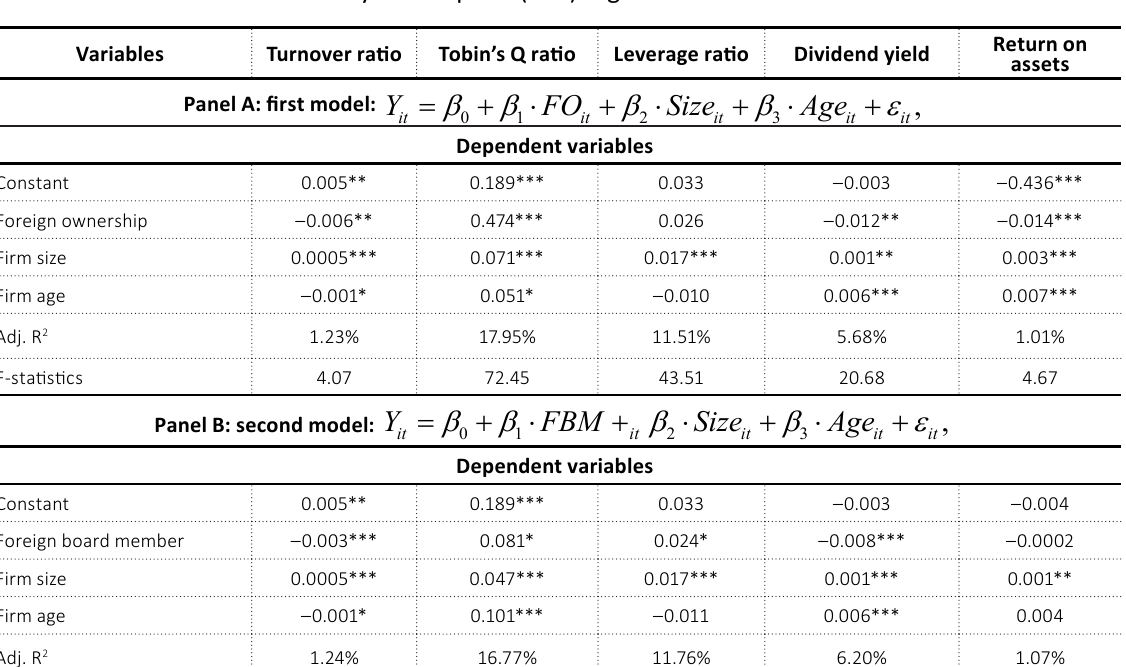
Table 4. Results based on ordinary least square (OLS)